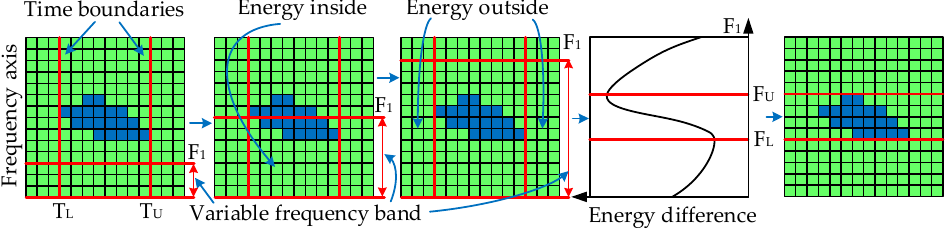
Entropy curve Figure 2. The schematic diagram of proposed IPSE. The instantaneous power spectrum entropy is calculated by Equations (2) and (3).